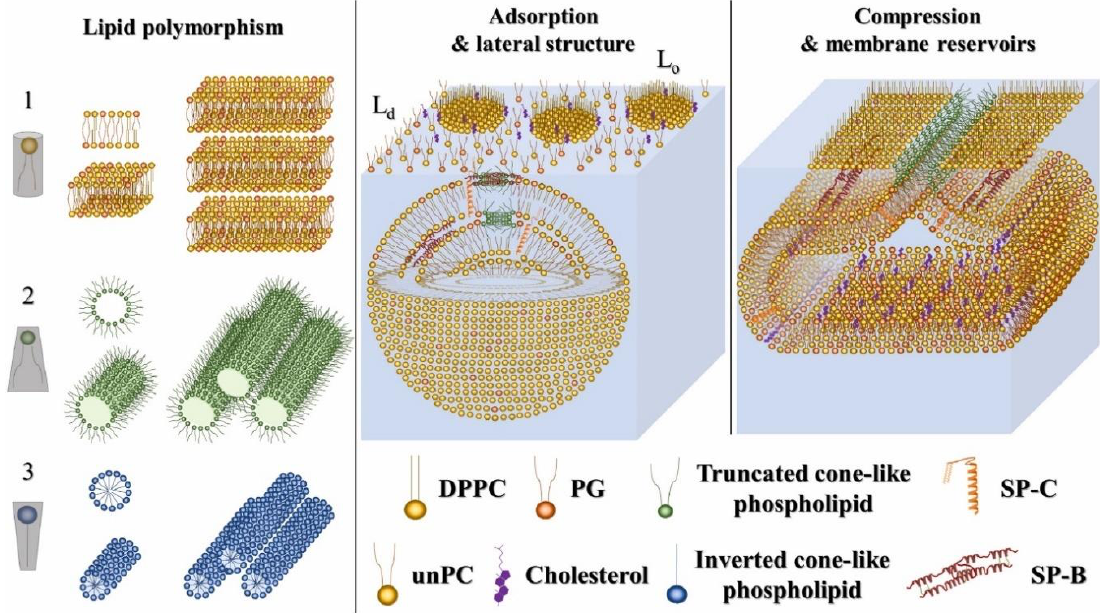
Figure 2. Different structures emerging in LS. Reprinted from Castillo-Sánchez et al. [72] , with permission under Open access CC BY 4.0 license, https://creativecommons.org/licenses/by/4.0/ (accessed on 20 December 2021).